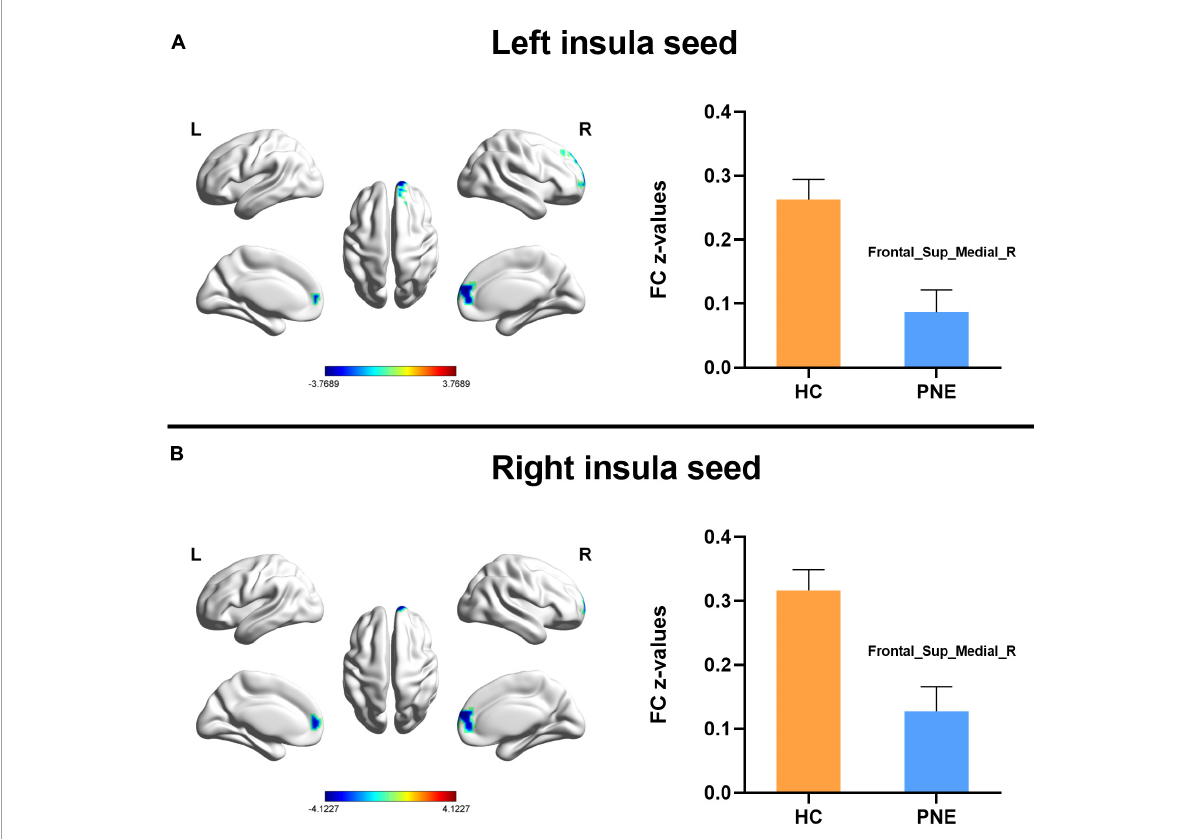
FIGURE1 Comparisons of the left and right insula-centered functional connectivity between PNE and HC children. The (A) left and (B) right insula seeds indicated reduced functional connectivity with Frontal_Sup_Medial_R (two-tailed GRF correction, P < 0.01 at single voxel, and P < 0.05 at cluster level). PNE, primary nocturnal enuresis; HC, healthy control; Frontal_Sup_Medial, medial superior frontal gyrus; L, left; R, right. Color scales: t -value; Error bars: SEM.